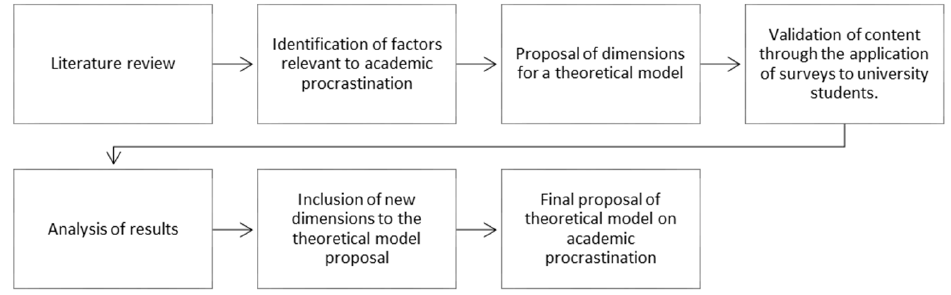
Figure 1. Summary of research stages.